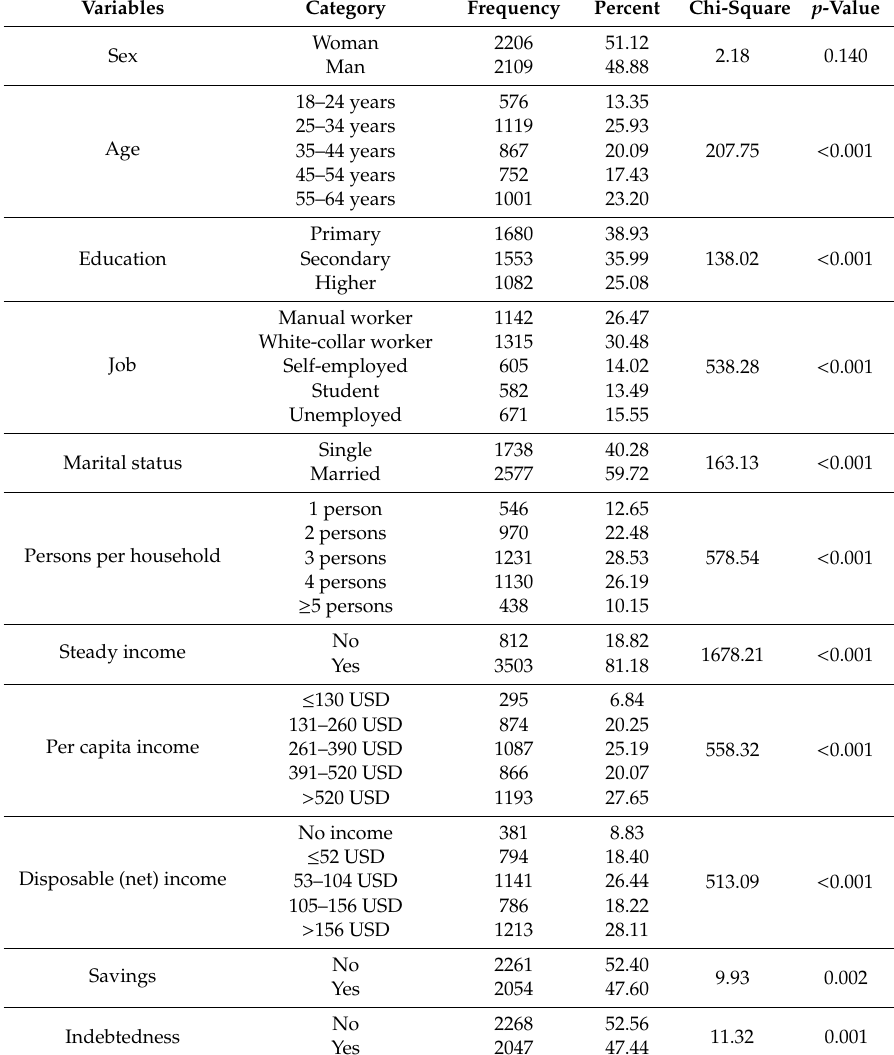
Table 1. Demographic and socioeconomic characteristics of the Wrocław residents under study ( n =